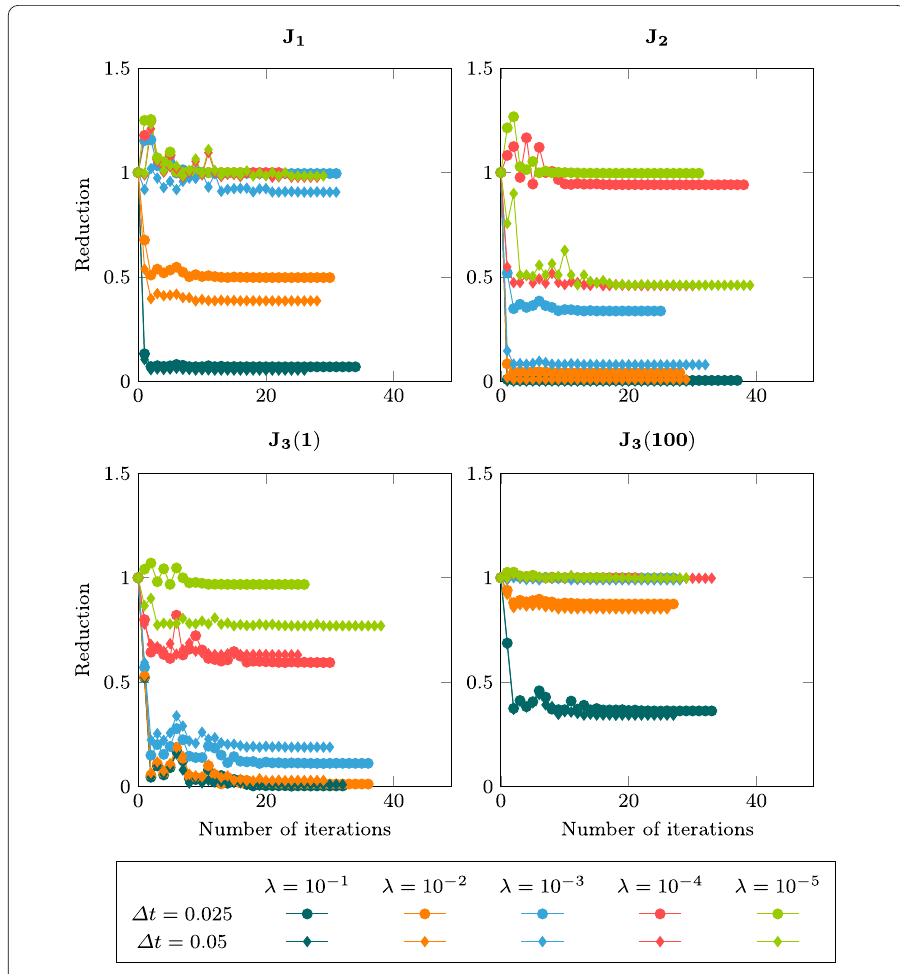
Figure 5 Optimization of gas flow rates. Reduction of the objective functionals during the optimization iteration, level 3, C S = 0.01, different time